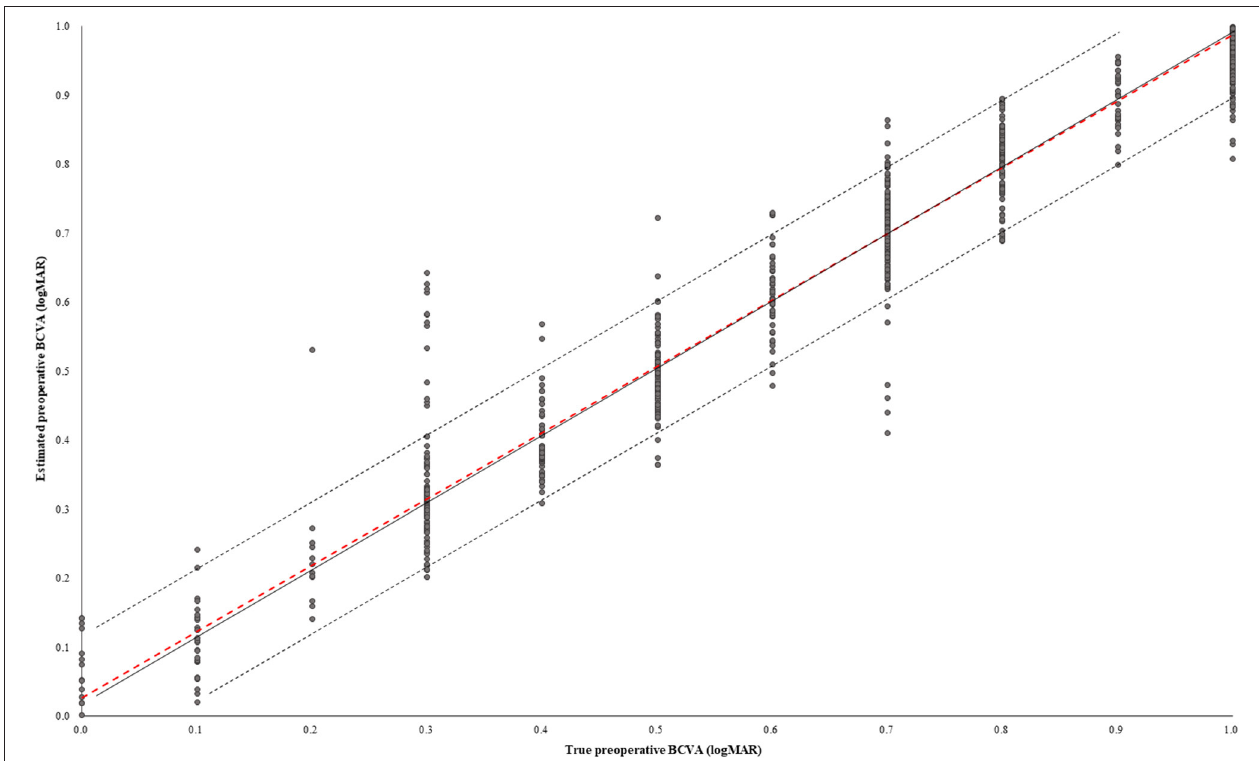
FIGURE 2 | Scatter plot between true preoperative BCVA and estimated preoperative BCVA. The solid black line shows that the true and estimated preoperative BCVAs were equal. The black dotted line shows the absolute error (AE) of the true and estimated preoperative BCVAs of 0.1 logMAR. The red dotted line describes the Pearson correlation coefficient. In the test dataset, 91.6% of cases had AE under 0.1 logMAR.